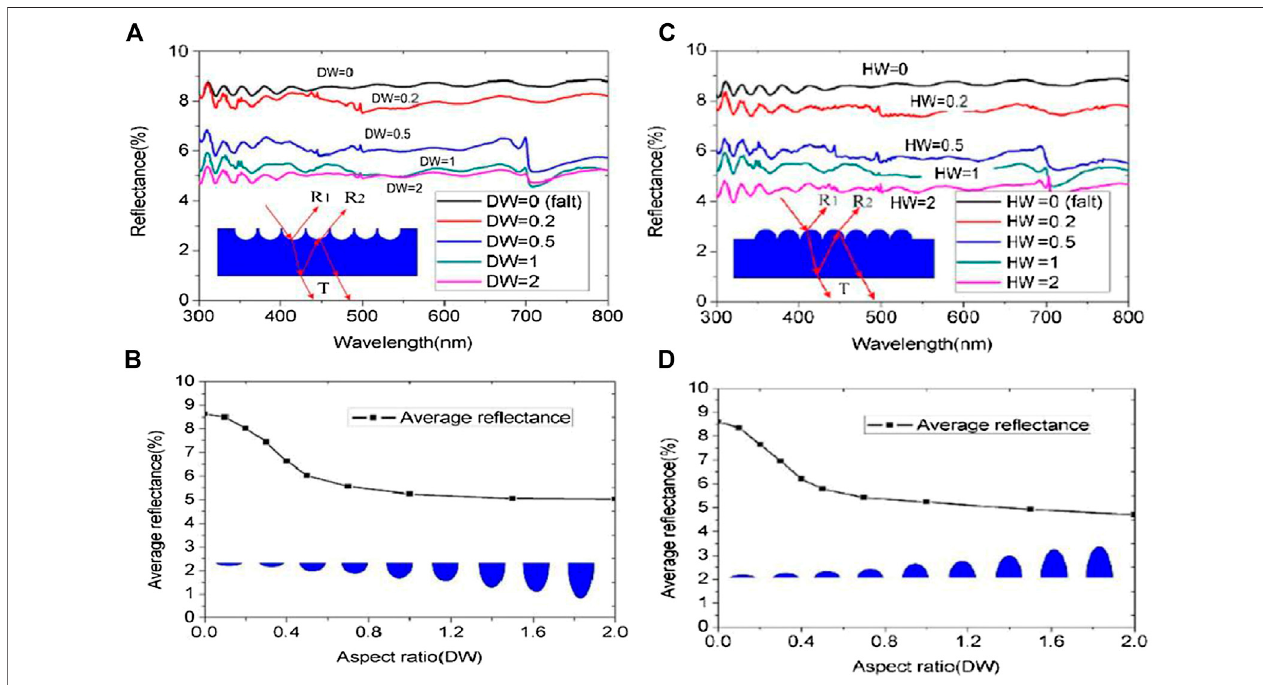
FIGURE 11 | (A) The re fl ectance curves of nano dimples structure with DW of 0, 0.2, 0.5, 1, and 2 respectively, and corresponding average re fl ectivity (B) . (C) The re fl ectancecurvesofnanoconvexballsstructurewithDWof0,0.2,0.5,1,and2respectively,andcorrespondingaveragere fl ectivity (D) . Source :ReproducedfromRef.32.